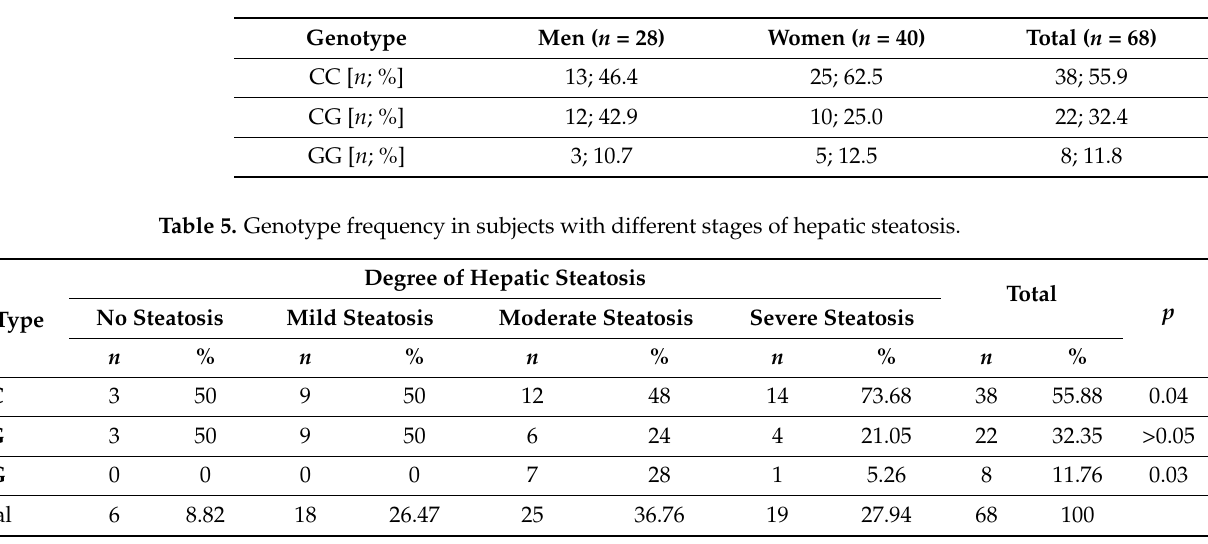
Table 4. Distribution of the PNPLA3 genotypes in the group studied.